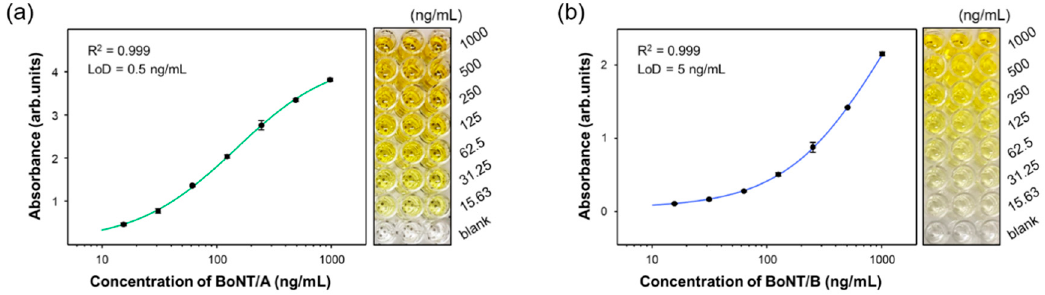
Figure 5. ELISA analysis using a 96-well plate and corresponding calibration curves for various concentrations of ( a ) BoNT / A and ( b ) BoNT / B toxins. The error bars indicate standard deviations from concentrations of ( a ) BoNT/A and ( b ) BoNT/B toxins. The error bars indicate standard deviations from three three measurements.